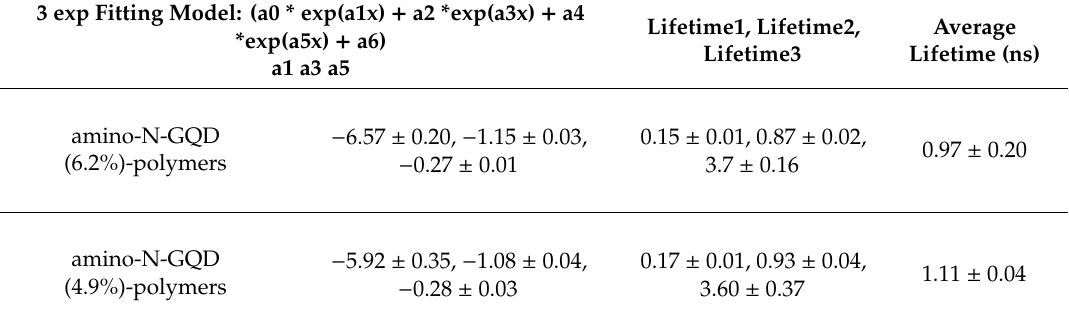
Figure 4. ( A ) Relative TPA spectrum of the amino-N-GQD (4.9%)-polymers. Signals were observed through TPE at various wavelengths (720–2820 nm) at 70.4 nJ pixel − 1 . ( B ) Relative TPL spectrum of the amino-N-GQD (4.9%)-polymers obtained under TPE (Ex / Em: 800 nm / 682 nm; 70.4 nJ pixel − 1 ; cuto ff of 700 nm as determined through cascading filters). ( C ) Dependence of TPL intensity on nanomaterial excitation power (logarithm), with the corresponding slope being approximately 2.00. The nanomaterial was subjected to TPE at 704.0–2816.0 nJ pixel − 1 (R 2 ≥ 0.999; Ex: 800 nm). ( D ) Time-resolved TPL decay profiles observed at room temperature (Ex: 800 nm, 70.4 nJ pixel − 1 ). The delivered dose of the material was 4 µ g mL − 1 in ddH 2 O. Table 2. Lifetime data and parameters generated using a time-correlated single-photon counting technique involving a triple-exponential fitting function for monitoring the emission at a wavelength of 800 nm under TPE. Material delivered dose: 4 µ g mL − 1 in ddH 2